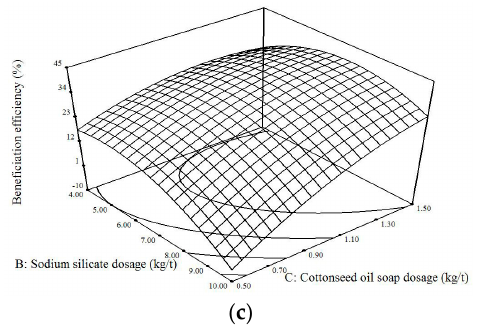
Figure 3. Effects of the reagent dosage and their interactions on the beneficiation efficiency: ( a ) effects of the sodium carbonate and sodium silicate dosage; ( b ) effects of the sodium carbonate and cottonseed oil soap dosage; ( c ) effects of the sodium silicate and cottonseed oil soap dosage.